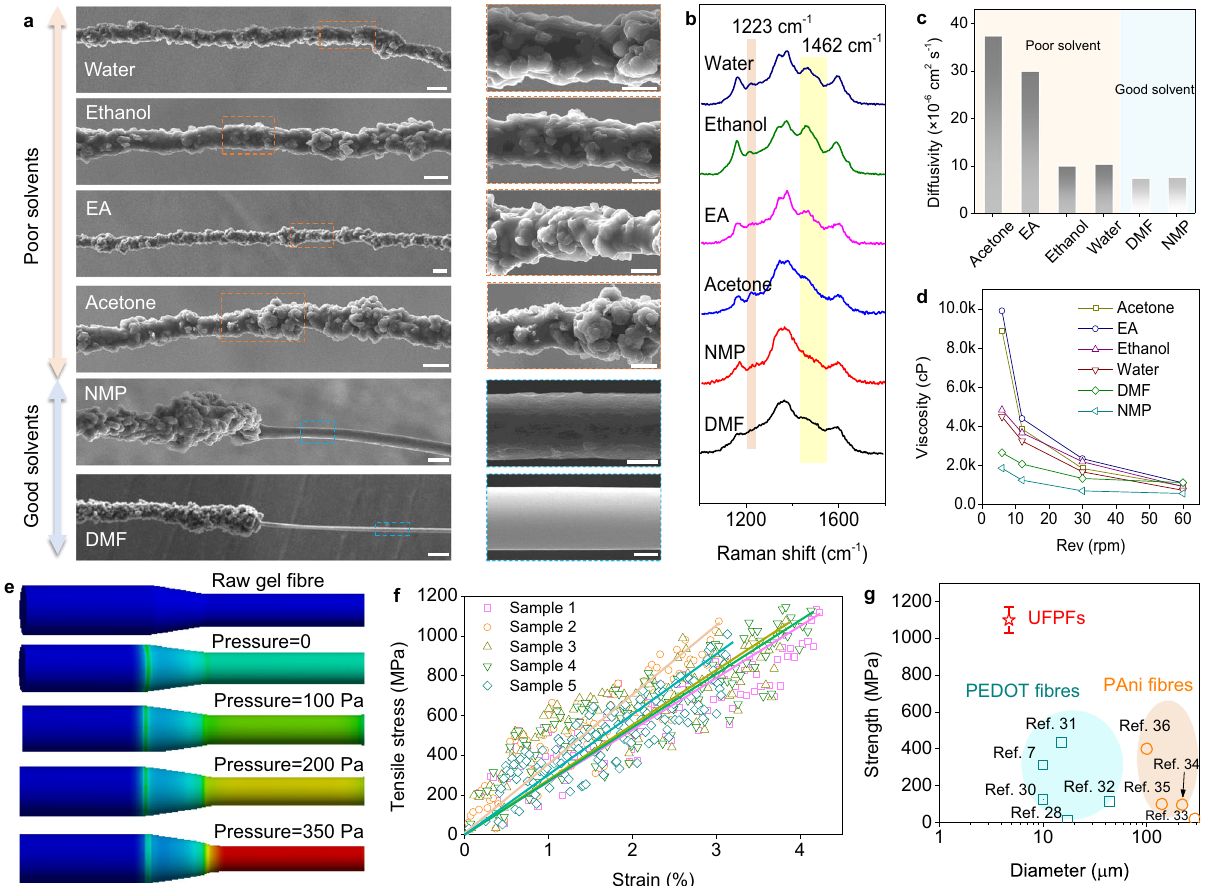
Fig. 2 Mechanism and mechanical properties of UFPFs. a SEM images of the PAni fi bers produced in different solvating species. Speci fi cally, the upper four panels show the fi bers prepared from poor solvents, and the lower two panels show the fi bers fabricated from good solvents. b Raman spectra of PAni fi bers after placing in air for four weeks. c The diffusivity from PAni dispersions (in m-cresol) to various solvating species. d The viscosity of PAni gels formed in various solvating species. e Mechanics simulation results of extension behaviors of PAni gel fi bers at different interfacial pressure. Comparing to the blue regions, the elements in blue regions are subject to larger stress. f Typical tensile stress-strain curves of UFPFs. g Ashby plot comparing the mechanical strength of UFPFs to previously reported CPFs. Scale bars in a: Water, Ethanol, EA, Acetone 20 µ m (left) 10 µ m (right); NMP 20 µ m (left) 5 µ m (right), DMF 20 µ m (left) 2 µ m